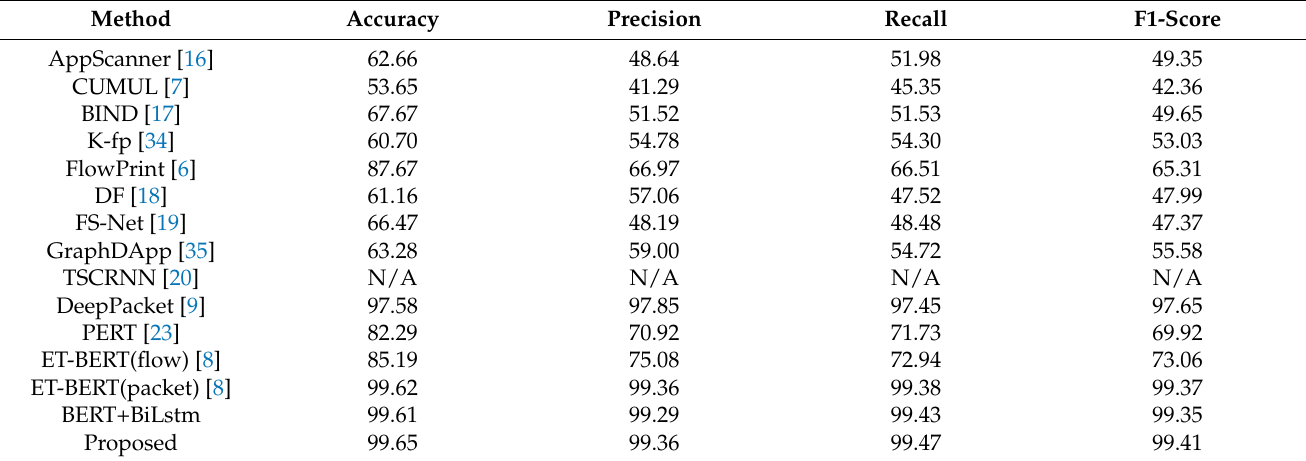
Table 7. Comparison results on application identification tasks